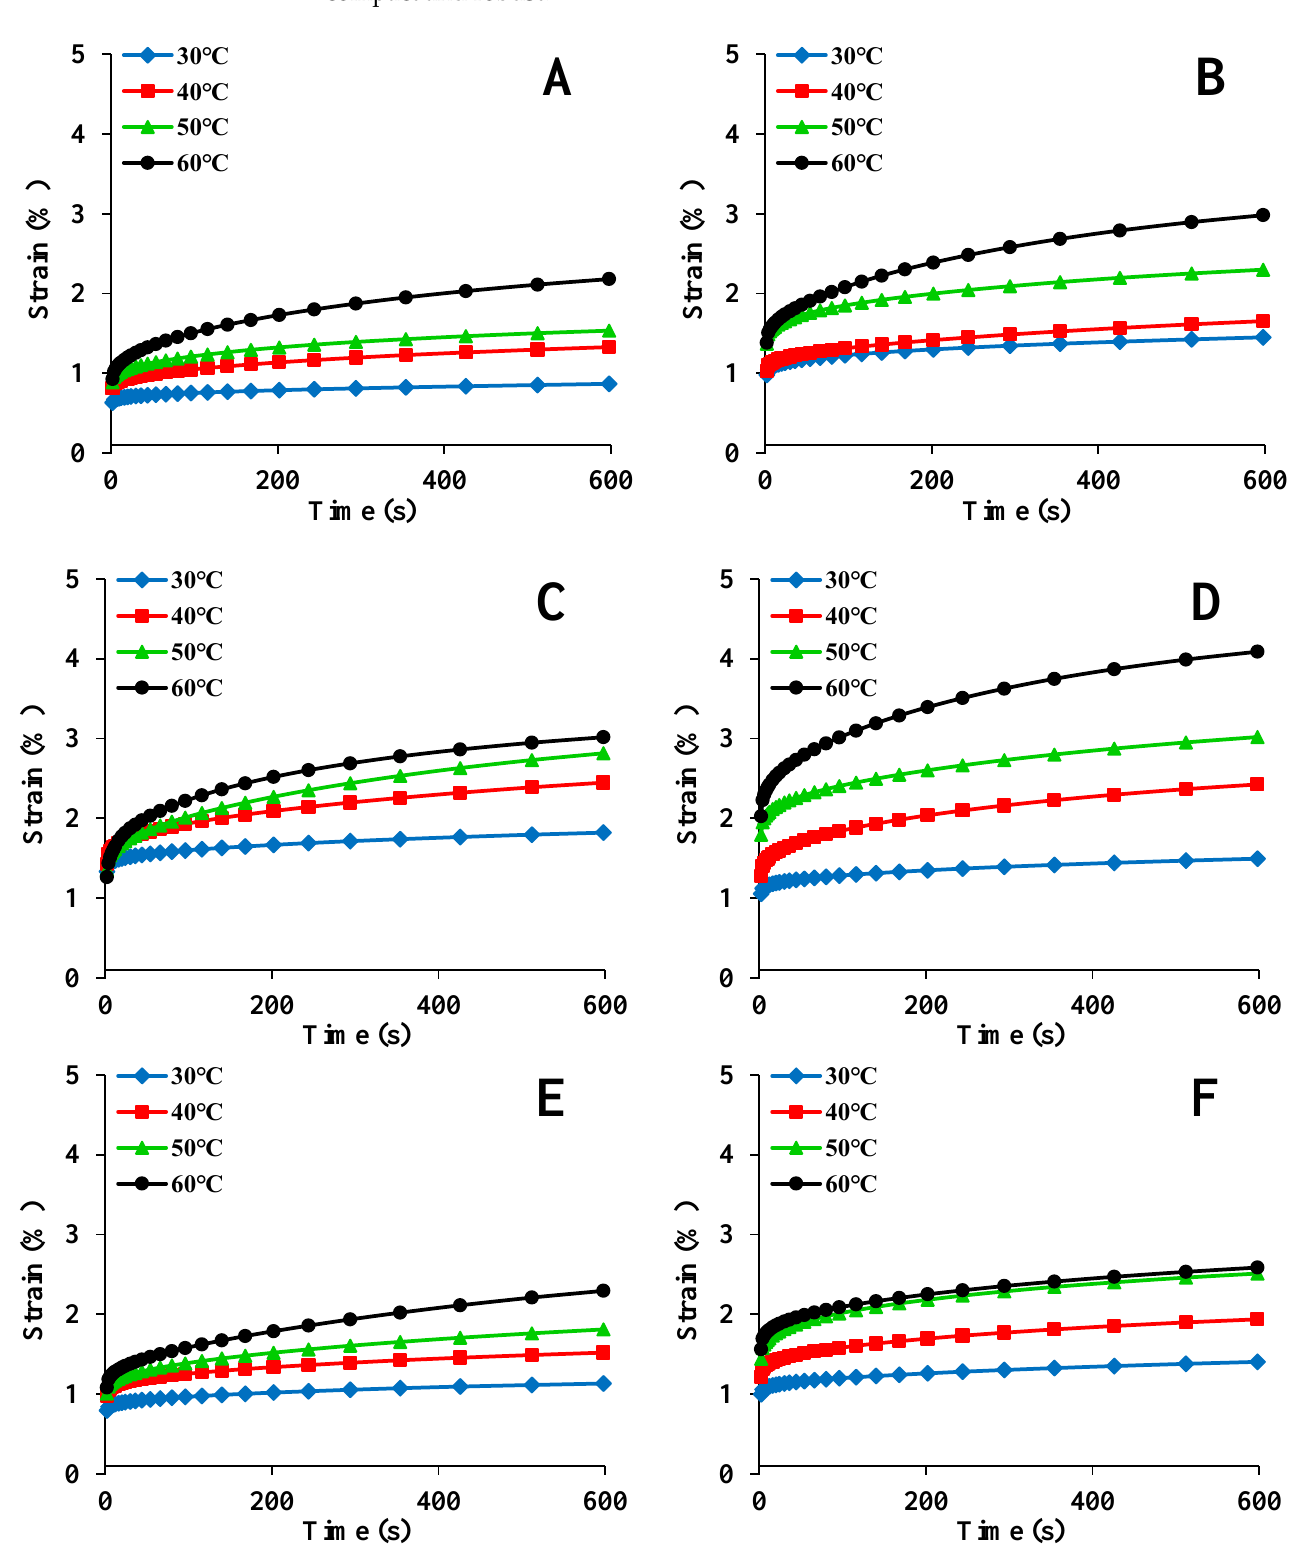
Figure 2. Creep data for maize kernels at different temperatures: ( A ) ND; ( B ) HVD 35 °C; ( C ) HVD 45 °C; ( D ) HVD 55 °C; ( E ) HVD 65 °C; ( F ) HVD 75 °C.